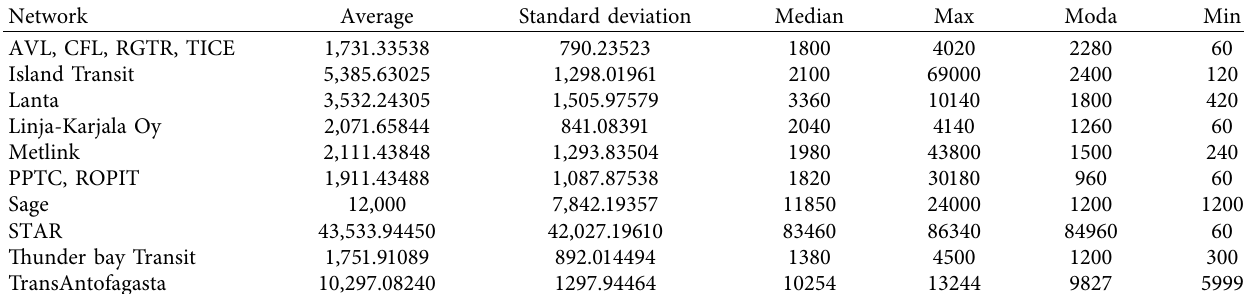
Table 9: Trip time metrics